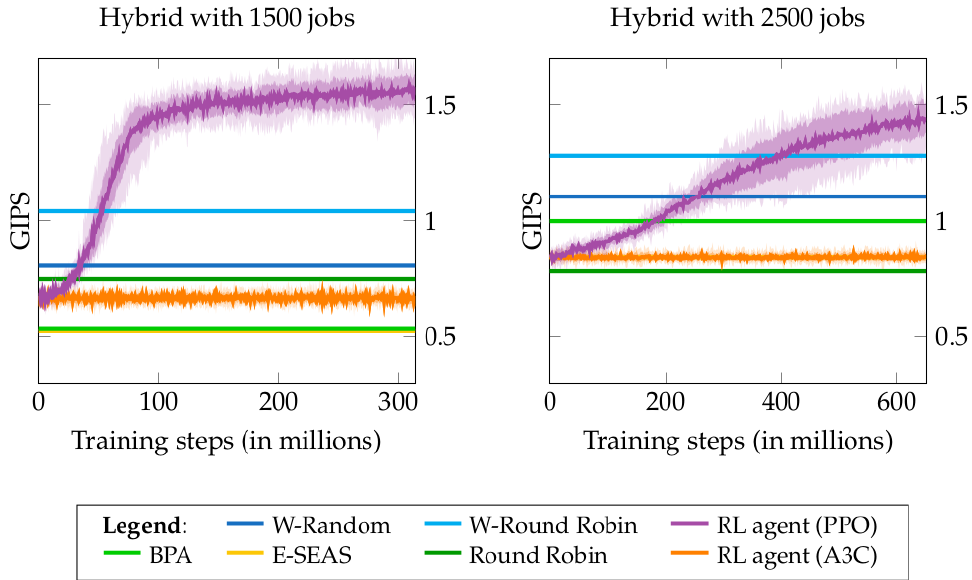
Figure 5. Training performance on the fixed job experiments. In both cases, the RL agent learned to distribute jobs better than existing state-of-the-art